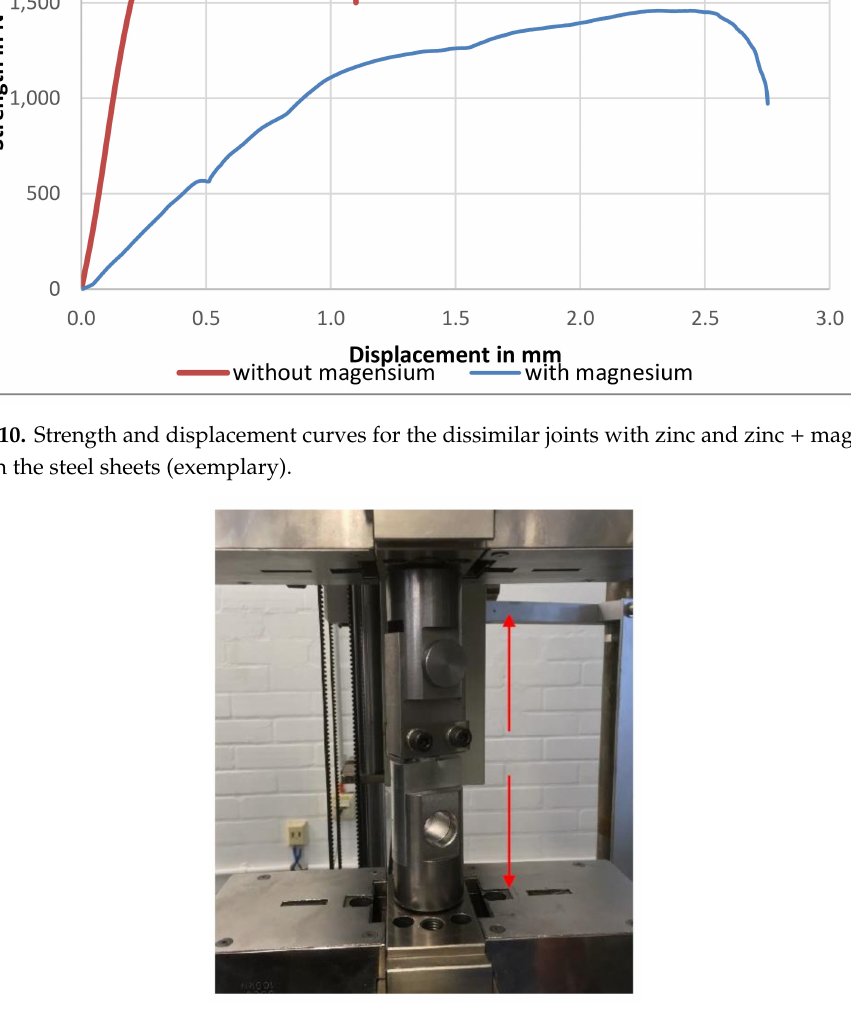
Figure 11. clamping device for the determination of tensile strength